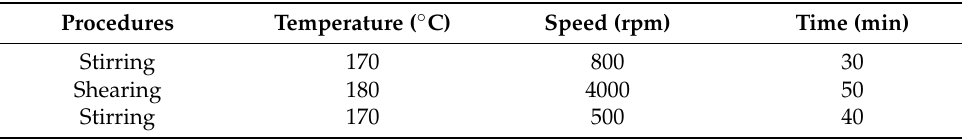
Figure 2. Schematic diagram of preparing CNTs/SBS-modified asphalt crack sealant.